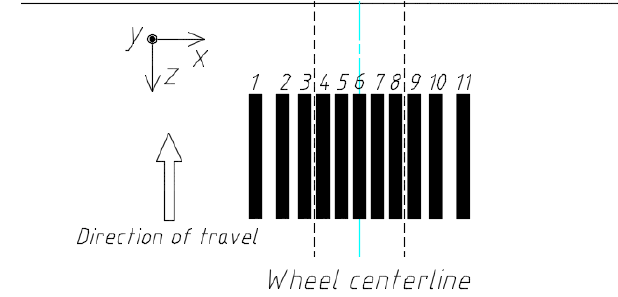
Figure 17. Placement of longitudinal sensors.